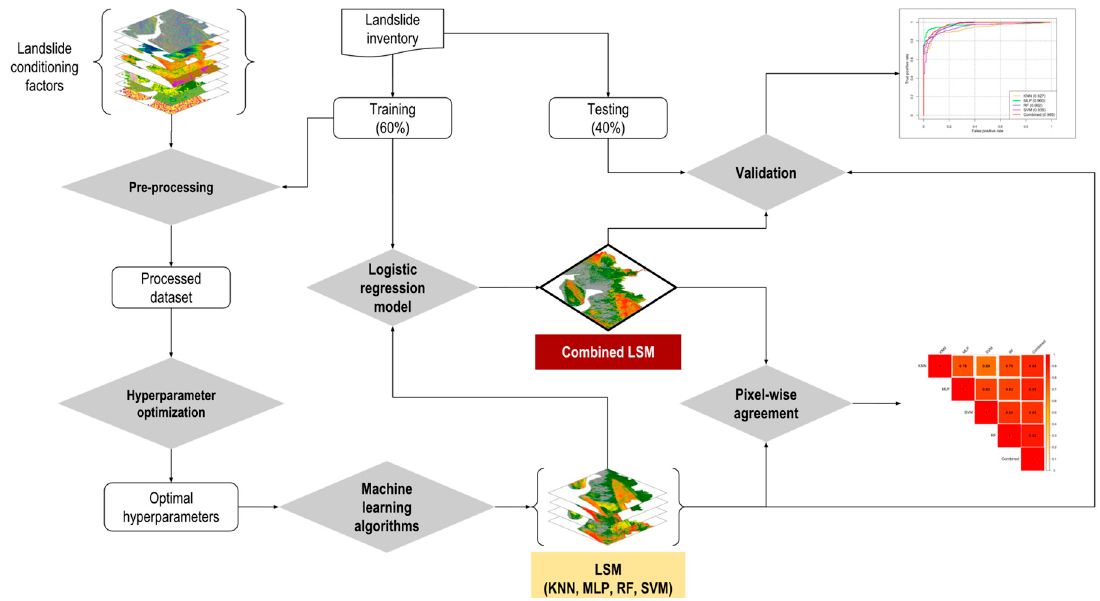
Figure 2. The process of evaluating spatial agreement among various machine learning technique-based landslide susceptibility maps and optimizing the landslide prediction map. LSM = landslide susceptibility maps; KNN = K-Nearest Neighbor; MLP = Multi-Layer Perceptron; RF = Random Forest; SVM = Support Vector Machine.